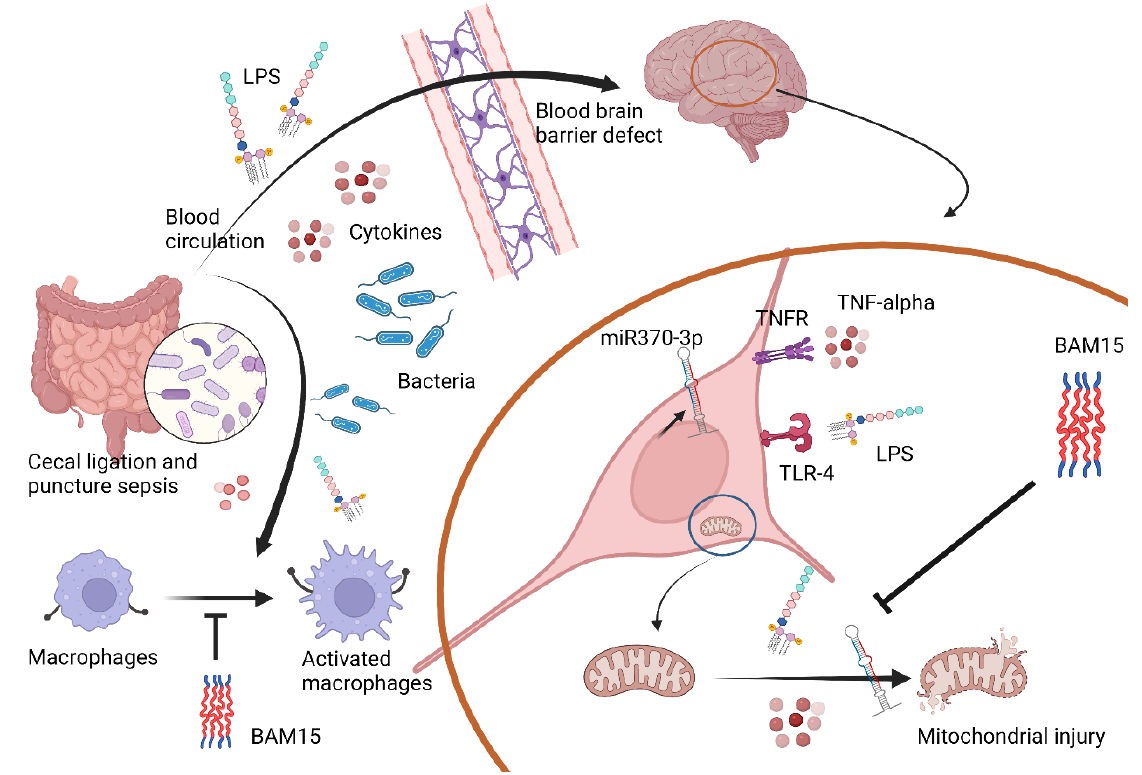
Figure 10. The proposed working hypothesis demonstrates the impacts of bacterial sepsis on brain cells and macrophages. In the brain, blood – brain barrier (BBB) defects in sepsis facilitate the translocation of several molecules, including cytokines, lipopolysaccharide (LPS), and bacteria into the brain. LPS and cytokines (especially TNF- α) upregulated miR370 -3p through TLR-4 and TNF recep-